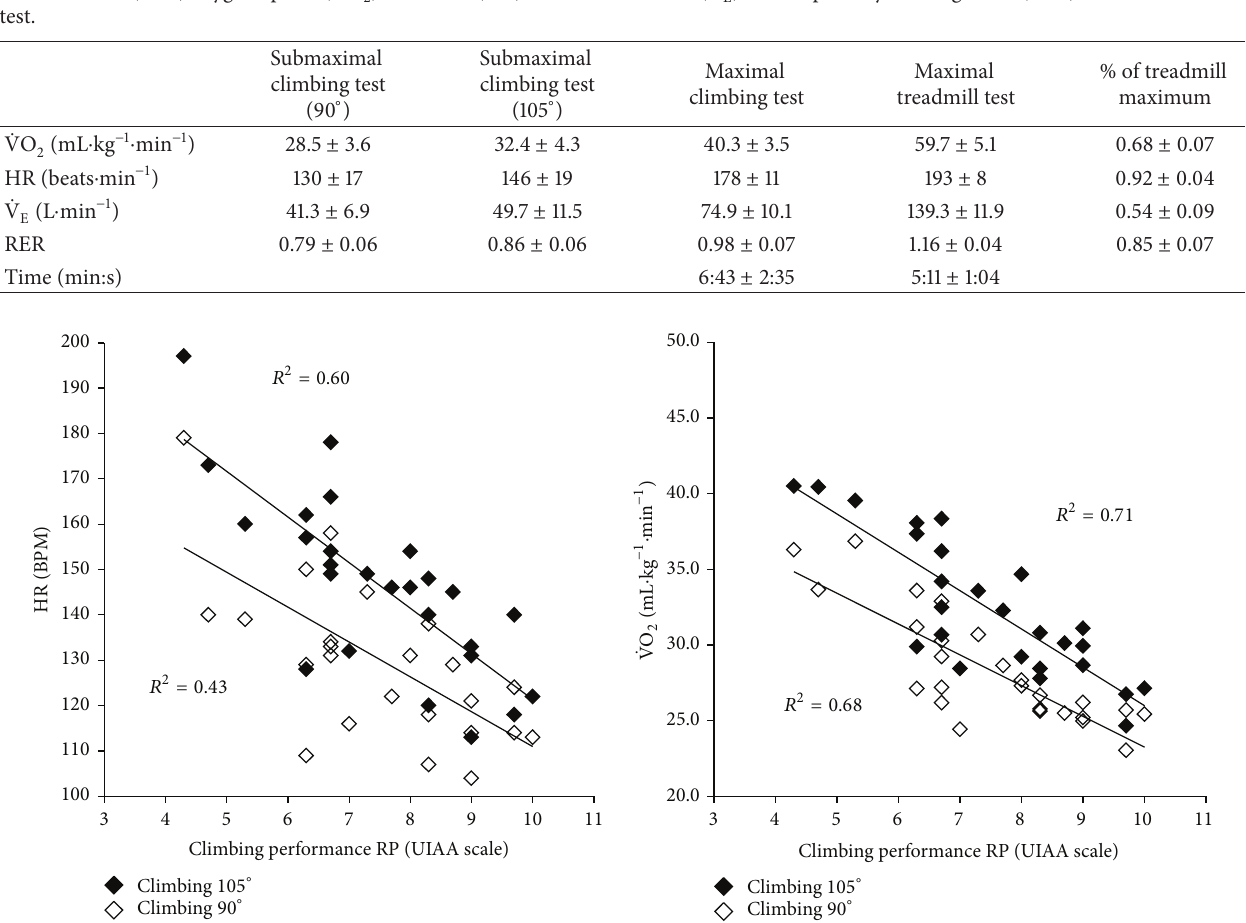
̇ VO ), heart rate (HR),minute ventilation ( 2